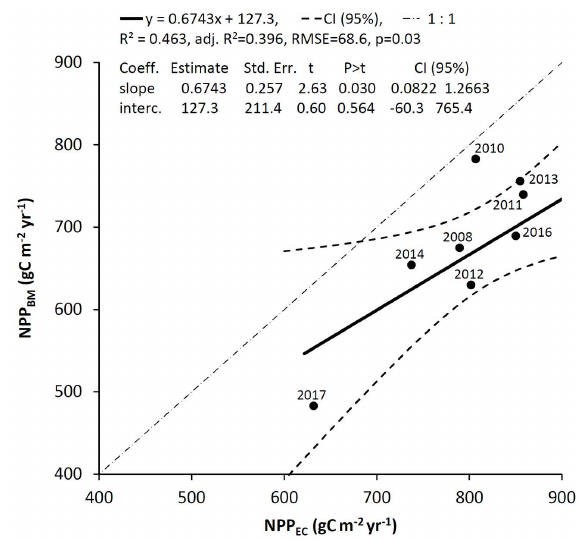
Figure 11. Comparison of NPP estimates from eddy covariance ( NPP EC ) and biometric measurements ( NPP BM ) at Jastrebarsko forest. Forests 2018 , 9 , x FOR PEER REVIEW